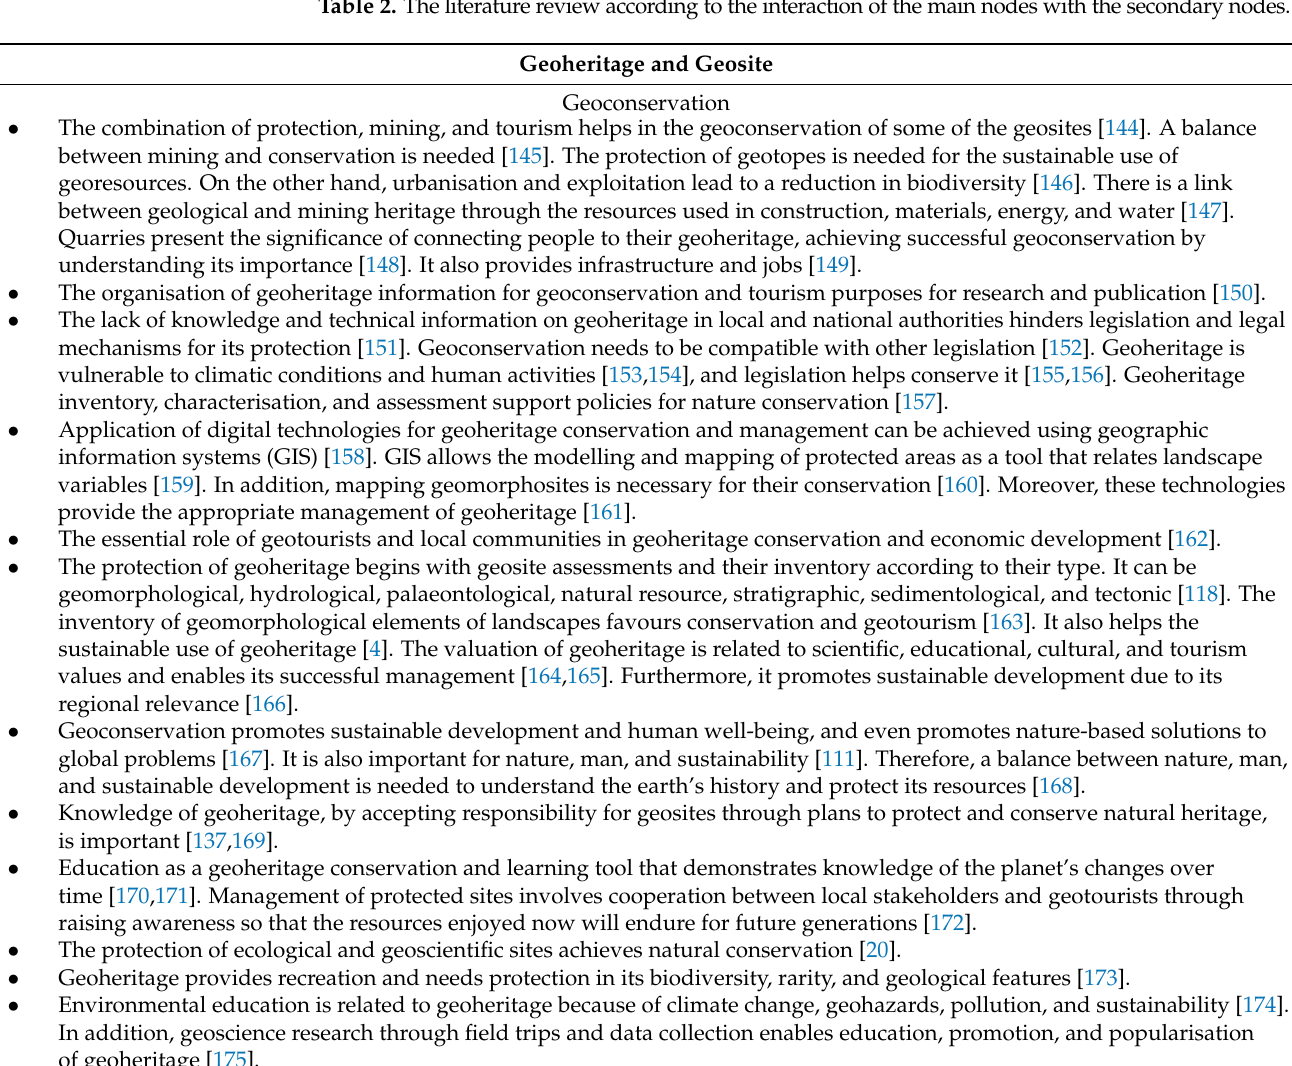
Table 2. The literature review according to the interaction of the main nodes with the secondary nodes. Geoheritage and